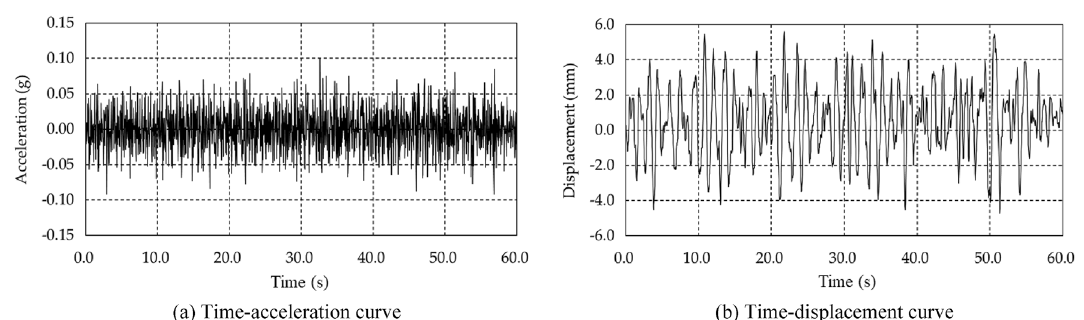
Figure 5. Acceleration acting on the shaking table and measured